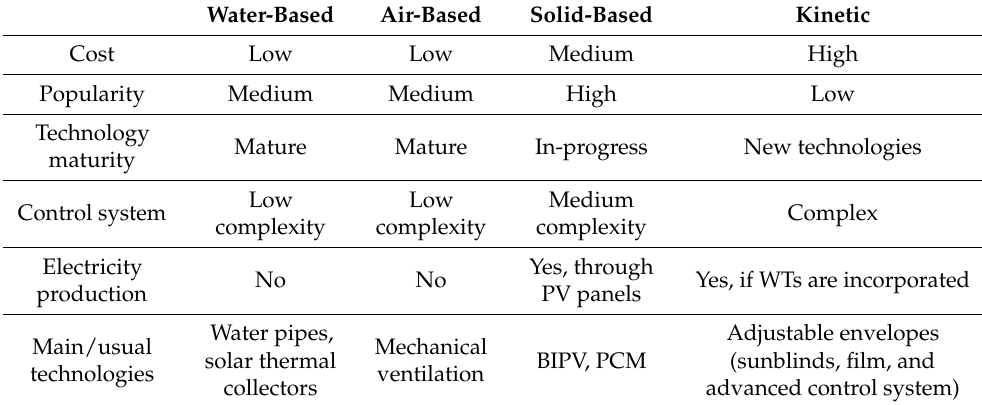
Table 2. Comparison of ADBE typologies